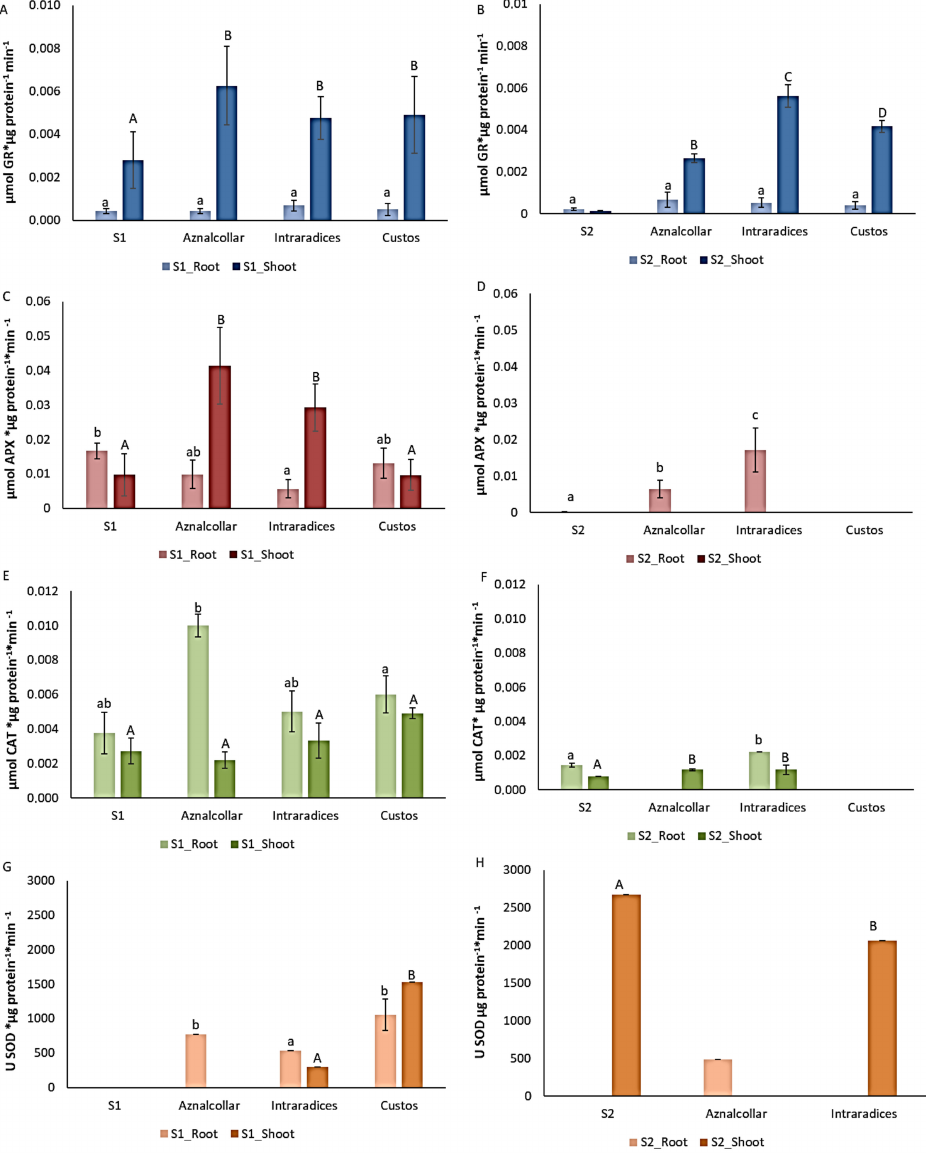
Figure 5. Enzymatic activities GR ( A , B ), APX ( C , D ), CAT ( E , F ) and SOD ( G , H ) in roots and shoots of control and mycorrhizal plants in soil 1 (S1, left column) and soil 2 (S2, right column). Error bars represent one standard deviation from the mean ( n = 3). Different letters indicate significant differences between treatments ( p < 0.05) according to Duncan post-hoc test: lowercase for S1 and capital letters for